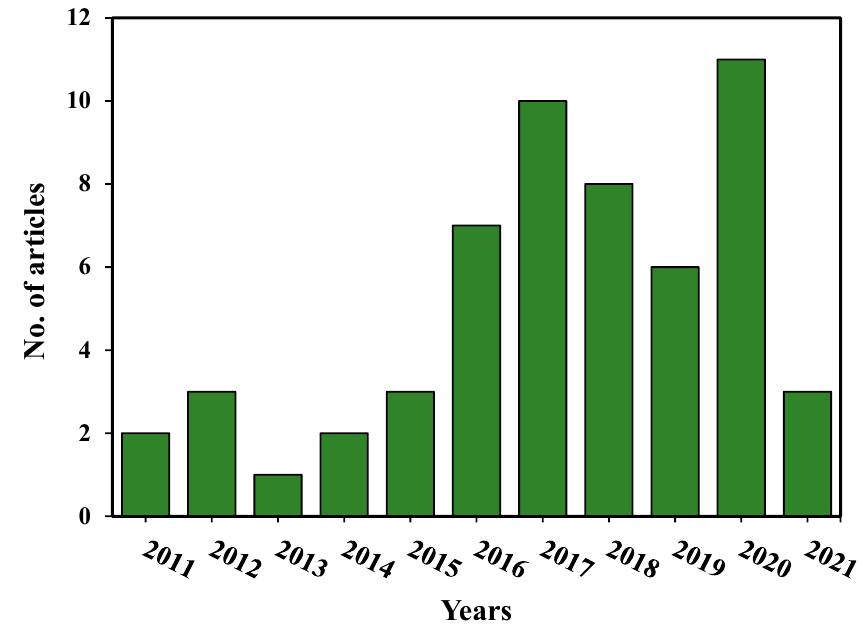
Figure 5. Published articles on POC per year.